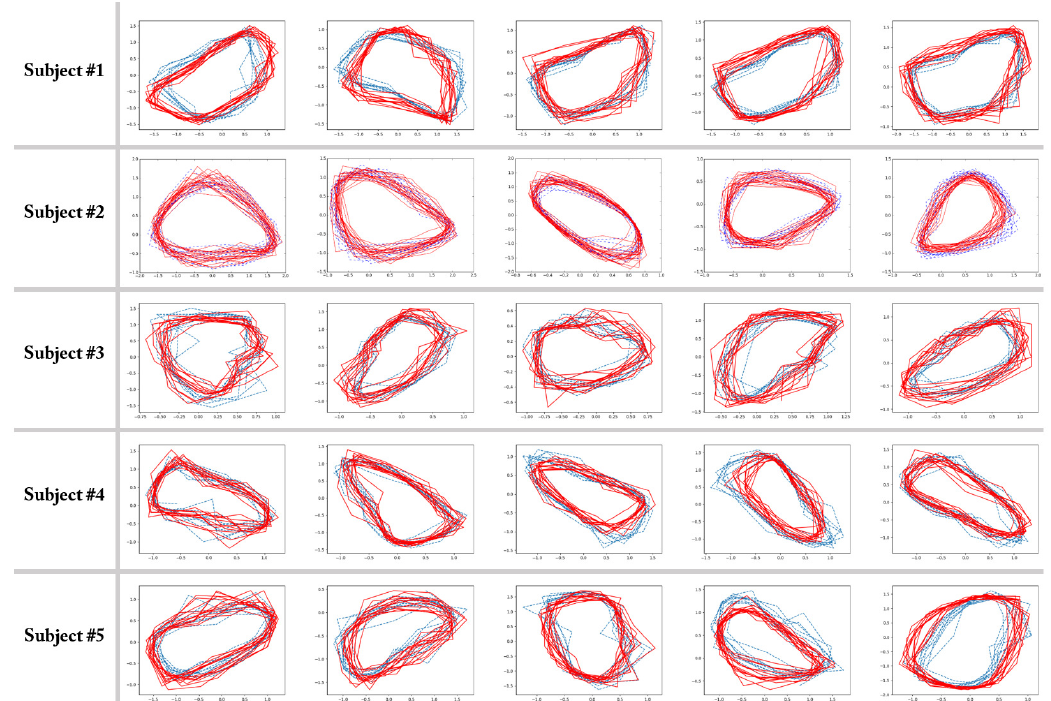
Figure 6. Latent trajectories learned from walking sequences using five-fold cross validation for five subjects (solid lines for test data, and dashed lines for training data). The subjects are the five male volunteers who are 27 years old, 75 kg, 188 cm; 28 years old, 59 kg, 166 cm; 25 years old, 60 kg, 176 cm; 27 years old, 63 kg, 169 cm; 24 years old, 112 kg, 168 cm. Note that there are no units for axes in latent